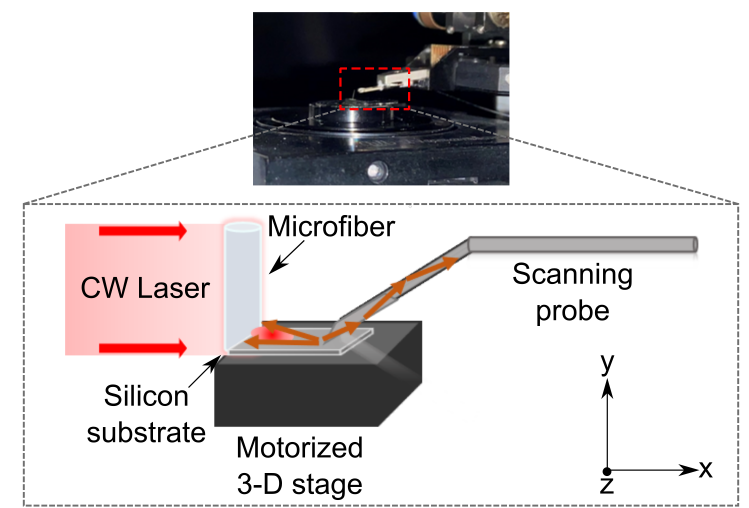
Figure 3. Experimental setup: ( top ) the photograph of the fiber on the substrate placed on the motorized stage while the NSOM probe scans the near-fields; ( bottom ) schematics of the experimental setup with the microfiber illuminated by the CW light and scanned via the NSOM probe.